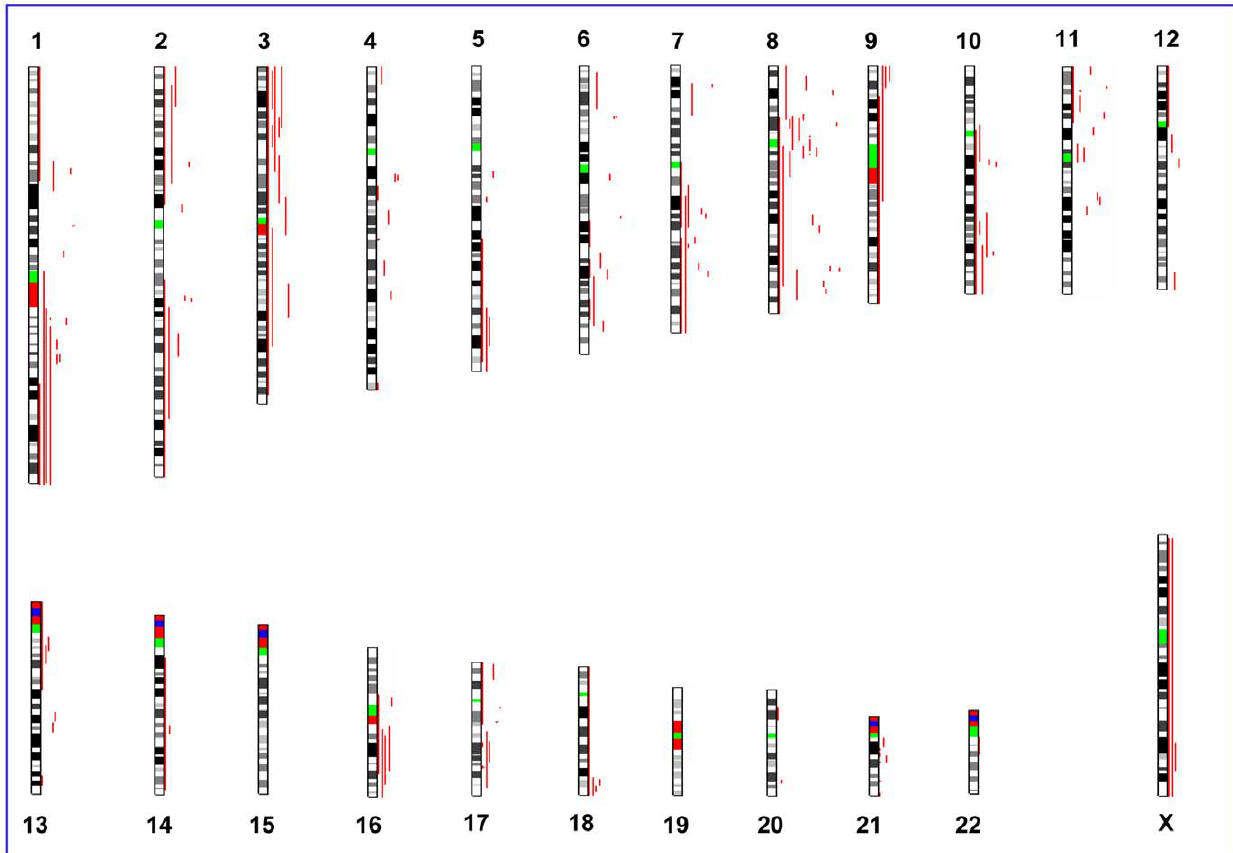
Figure 3. Distribution of aUPD in HER2/neu-positive breast cancer samples.